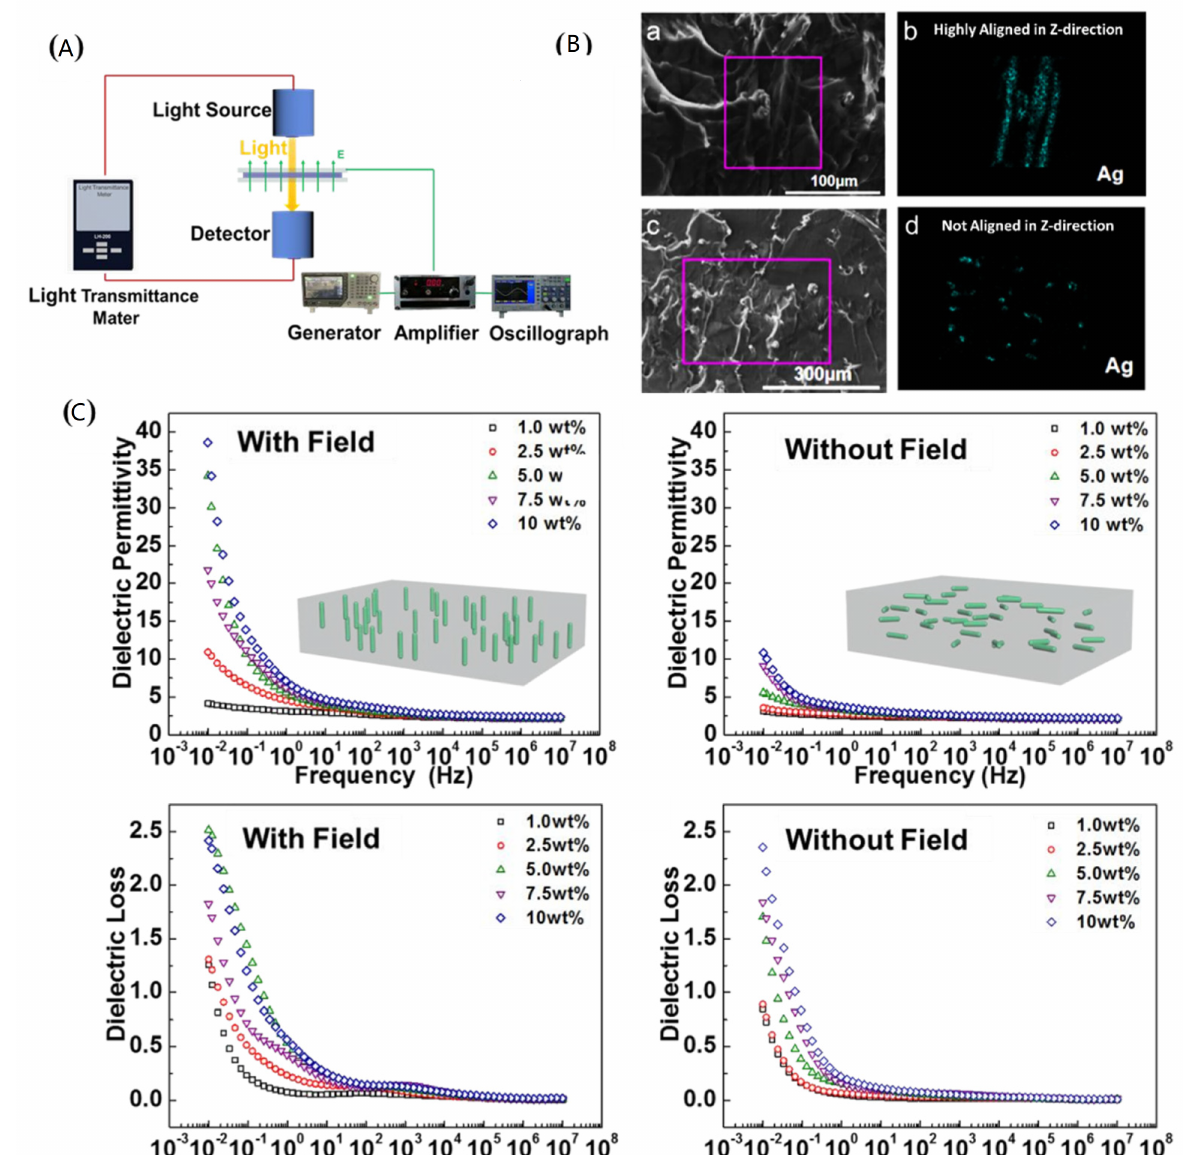
Figure 11. ( A ) Preparation of high dielectric composites by electric fields. ( B ) SEM image of oriented structures. ( C ) Dielectric properties of composites after orientation. Adapted with permission [101]. Copyright 2020, American Chemical